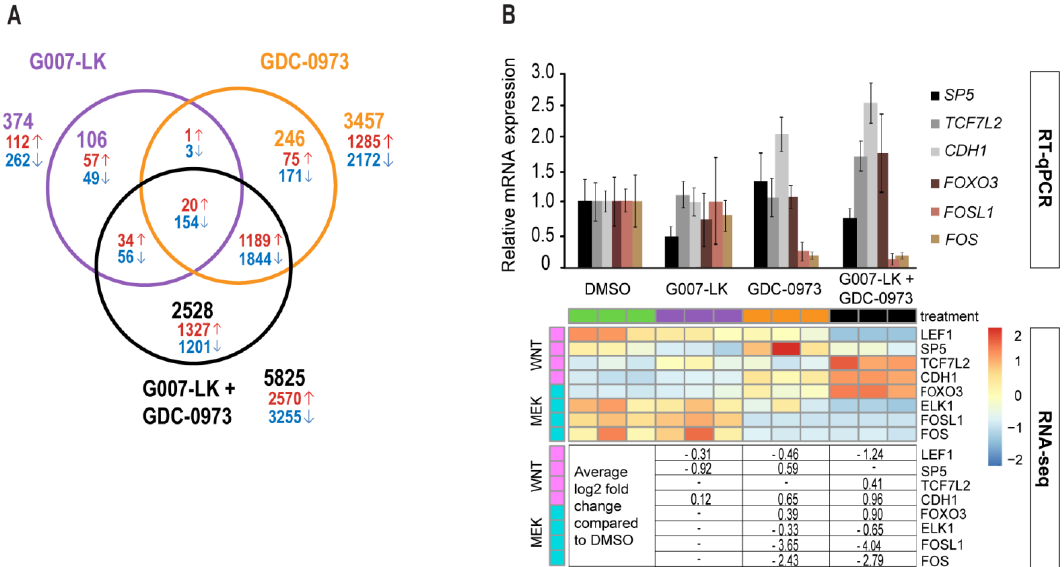
Figure 3. RNAseq analysis of TNKSi and MEKi treated HCT-15 cells. RNAseq count data was analyzed using the count-based statistical method DESeq2. A Venn diagram was created of differentially expressed genes (DEG’s) between the inhibitor treated samples (average of triplicates) compared to the DMSO control (> ±0.5 logfold, padj < 0.1) ( A ). Red numbers indicate upregulated genes, while blue numbers indicate downregulated genes. Purple numbers indicate TNKSi regulated genes, orange numbers indicate MEKi regulated genes, and black numbers indicate combined TNKSi/MEKi regulated genes. The transcriptional changes in a small selection of canonical WNT ( LEF1 , SP5, TCF7L1 and CDH1 ) and MEK/ERK ( FOXO3, ELK1, FOSL1 and FOS ) downstream target genes were investigated for their response to inhibitor treatments. The transcription level of SP5, TCF7L1, CDH1, FOXO3, FOSL1 and FOS genes were verified with RT-qPCR on cDNAs created from the same RNA samples as the sequenced RNA ( B ). RT-qPCR data shows mean relative expression values ( ± STDEV) from the 3 biological replicates, each with 3 technical replicates. Gene transcription levels were normalized to internal GAPDH levels, and are shown as relative to the DMSO control. Individual RNAseq data for the selected genes are visualized with a heatmap, and the average log2 fold changes in gene transcription are indicated in the table below. Only log2 fold changes with a p -value < 0.05 are shown. Heatmap Scale bar (red = high, yellow = medium and blue = low) indicates relative differences in log2 fold change within each row.